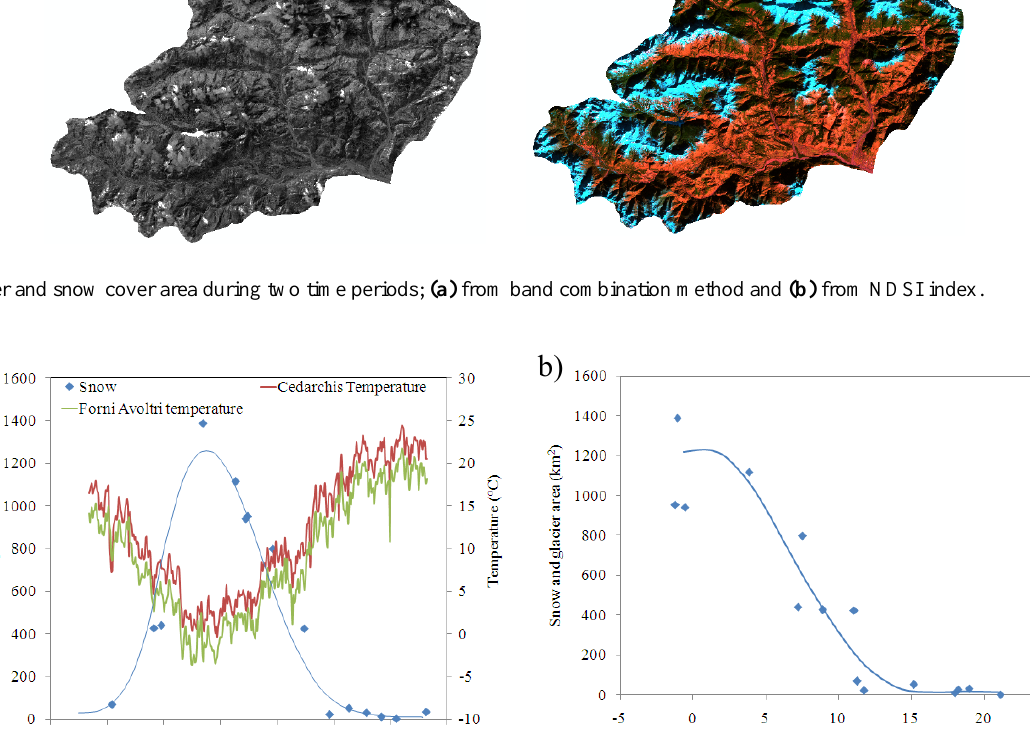
Fig. 4. (a) Temporal changes in snow and glacier cover. (b) Variations in snow and glacier cover with respect to the three-day mean temperature averaged for all meteorological stations.